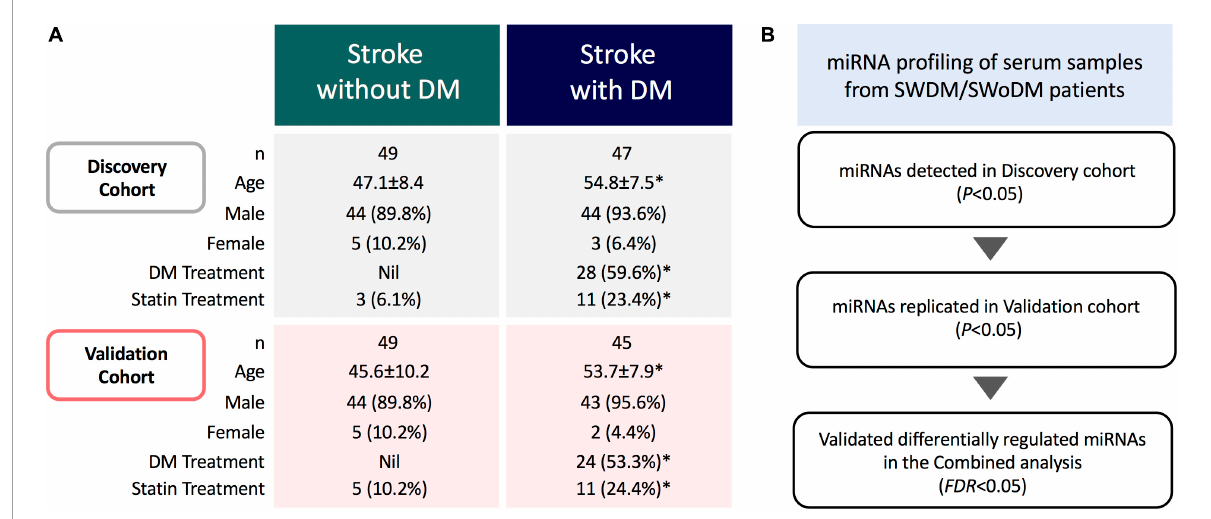
FIGURE1 Study cohort and analysis workflow. (A) The study comprised acute ischemic stroke patients with and without type 2 diabetes mellitus (SWDM; n = 92, SWoDM; n = 98). Patients were randomly divided into discovery and validation cohorts with comparable distribution of covariates (age, gender, diabetes and statin treatment). Statistically significant parameters ( P < 0.05) between SWDM and SWoDM patients are marked with an asterisk (*). (B) Serum samples were collected within 24 h of clinical diagnosis of acute ischemic stroke from SWDM and SWoDM patients. Differentially regulated and statistically significant miRNAs detected in the discovery dataset generated from miRNA transcripts by RNA-Seq were investigated in the validation dataset. Combined analysis was then performed to identify FDR-significant miRNAs presented as validated differentially regulated miRNAs in SWDM compared to SWoDM